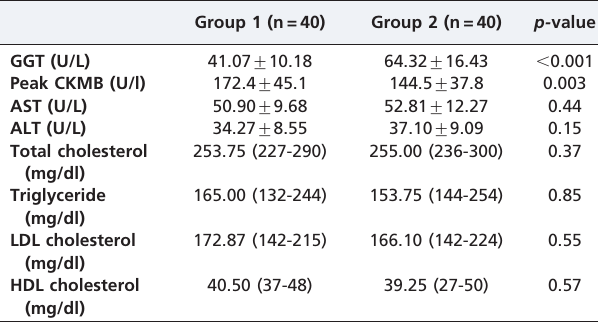
Table 2 - Baseline biochemical characteristics of the study